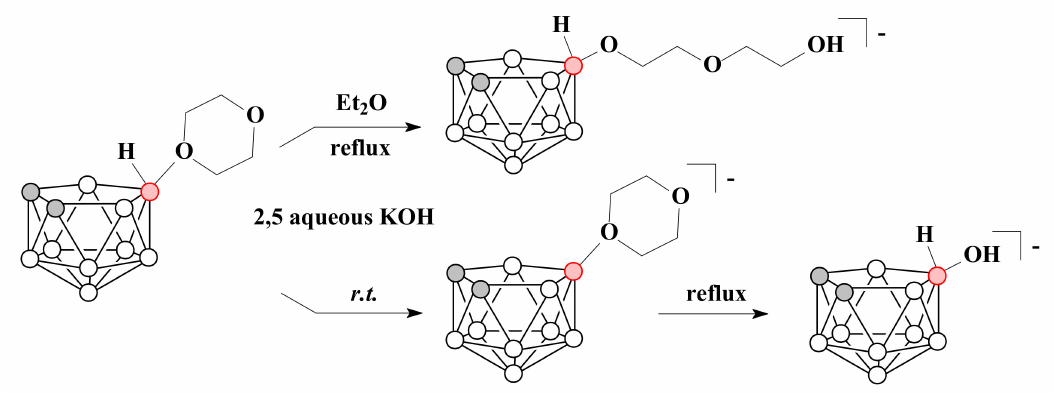
Scheme 19. The reactions of 1,4-dioxane derivative of nido -carborane with KOH. The ring-opening reactions of 1,4-dioxane derivative of nido -carborane with dimethyl sulfide or triphenylphosphine gave the corresponding sulfonium and phosphonium deriva- tives 10-L-CH 2 CH 2 OCH 2 CH 2 O-7,8-C 2 B 9 H 11 (L = SMe 2 , PPh 3 ). Subsequent treatment of these compounds with a base such as potassium tert -butoxide in both cases led to a side chain shortening product [10-HOCH 2 CH 2 O-7,8-C 2 B 9 H 11 ] − [87] (Scheme 20).